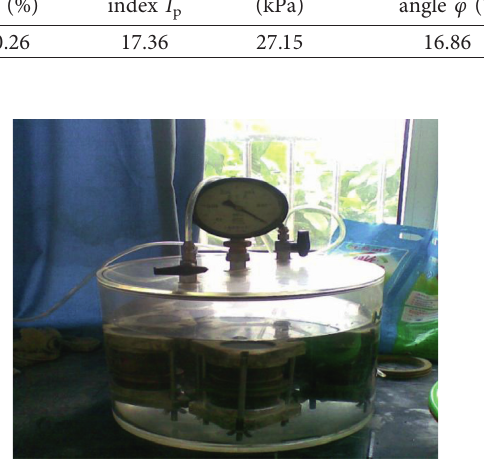
Figure 4: Sample